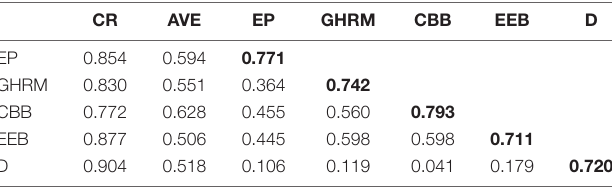
TABLE 4 | Discriminant validity.